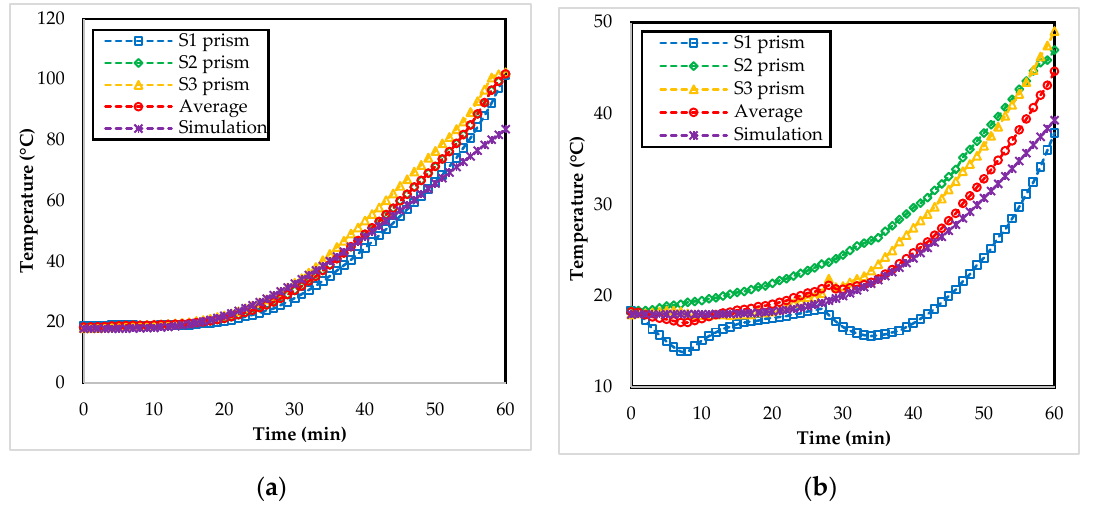
Figure 7. Temperature profile: ( a ) depth of 60 mm (prisms); ( b ) depth of 80 mm